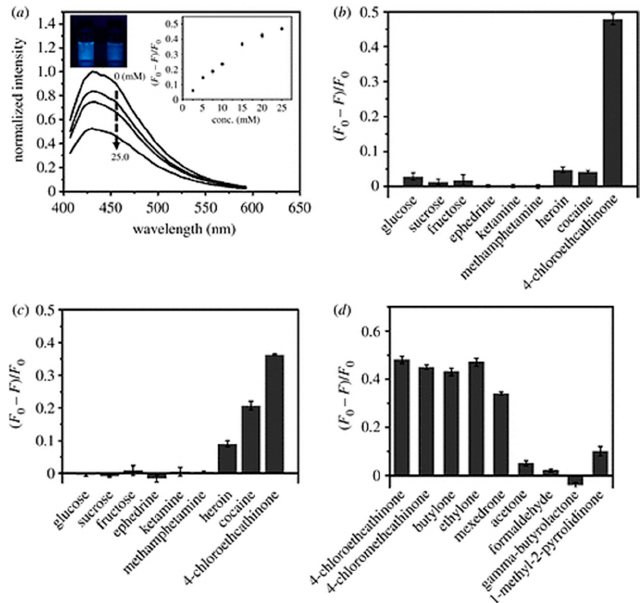
Figure 17. Fluorescence quenching of C-dots in aqueous suspension: ( a ) variation in fluorescence quenching at pH 11 by 4-chloroethcathinone concentration; ( b ) fluorescence quenching by a range of compounds at pH 11; ( c ) florescence quenching by the same compounds at pH 7; in ( b ) and ( c ), concentrations of glucose, sucrose, fructose, ephedrine, methamphetamine and 4-chloroethcathinone are 25.0 mM and the others are saturated; ( d ) fluorescence quenching by a range of ketones (all concentrations 25.0 mM), showing significant quenching only by those which are π -conjugated. Reproduced with permission from reference [79], Royal Society Open Science; published by The Royal Society Publishing,